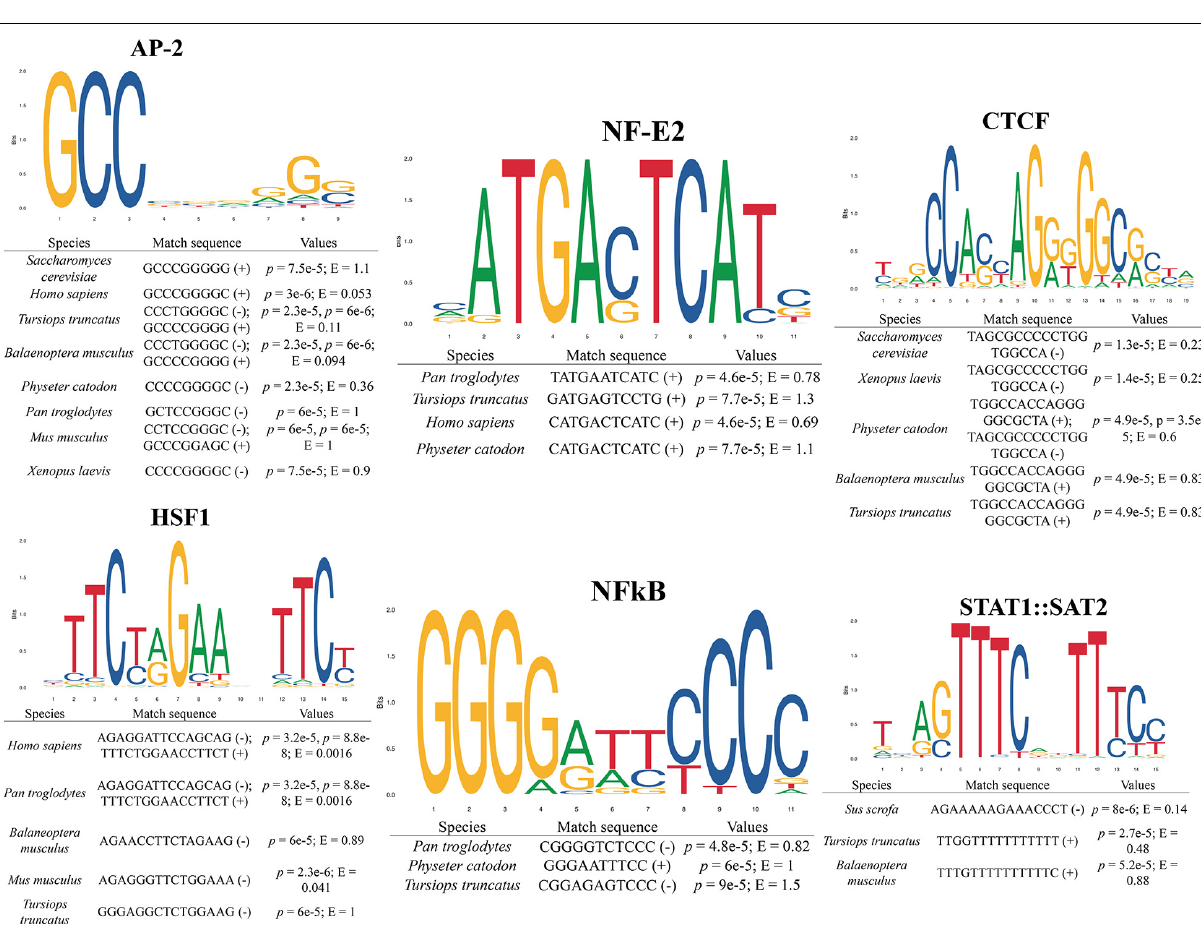
Frontiers in Physiology |